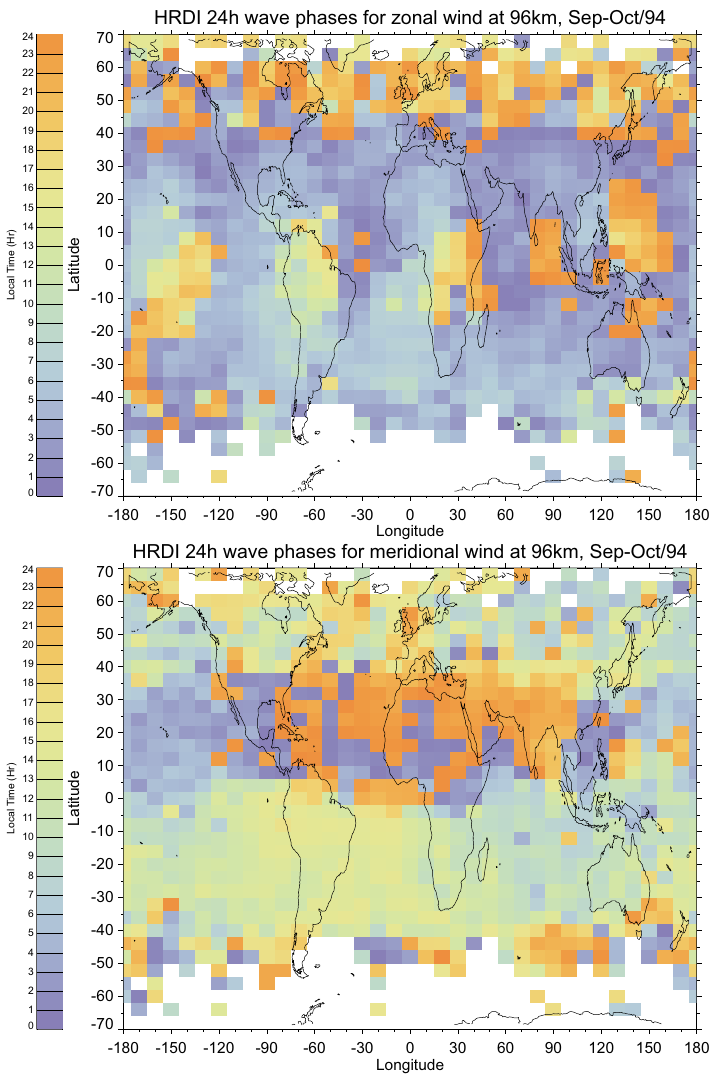
Fig. 6. Contoured plots of 24-h tidal phases for September–October 1994 from